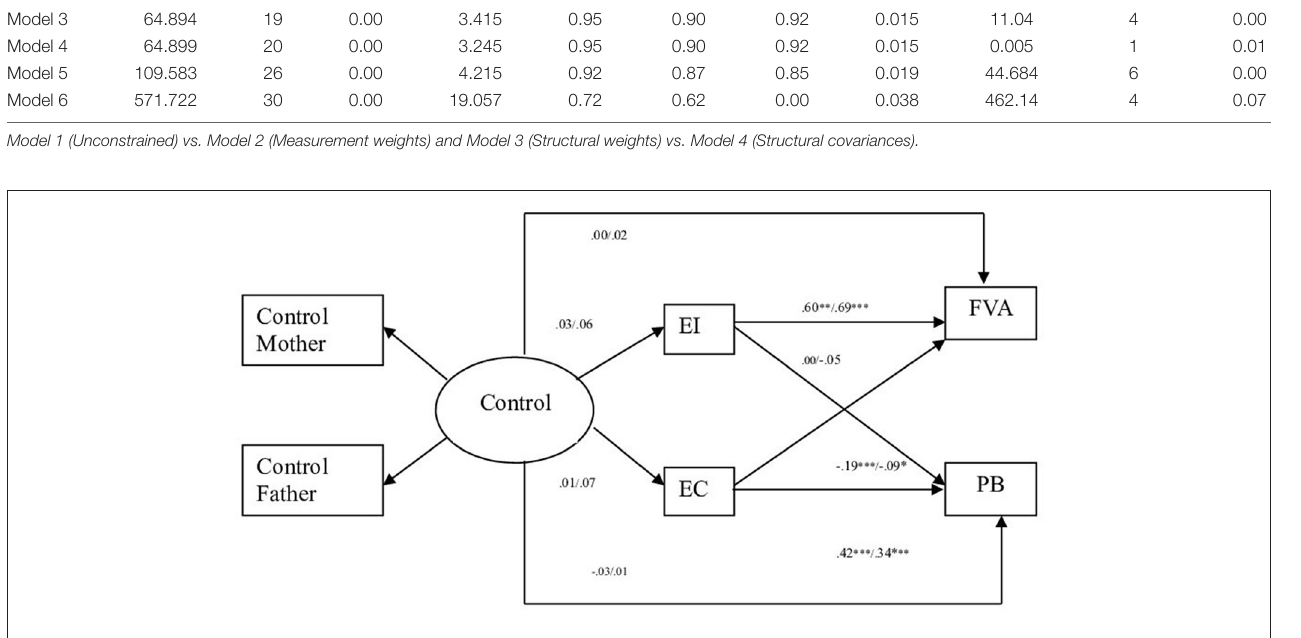
FIGURE 2 | Path standardized coefficient values of offenders and non-offenders pertinent to parental style negative control. Standardized Values. EI, Emotional Instability; EC, Empathic Concern; FVA, Physical and Verbal Aggressive Behavior; PB, Prosocial behavior. *** p < 0.001, ** p < 0.01, * p < 0.05. Non offenders left value, offenders right